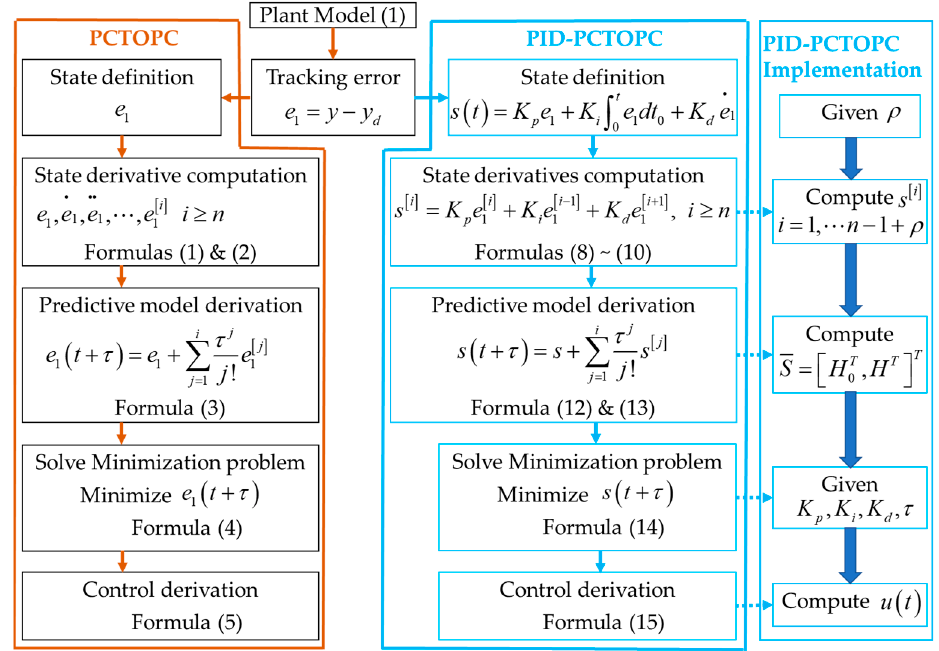
Figure 1. Connections and comparisons between the PCTOPC and the PID-CTOPC.